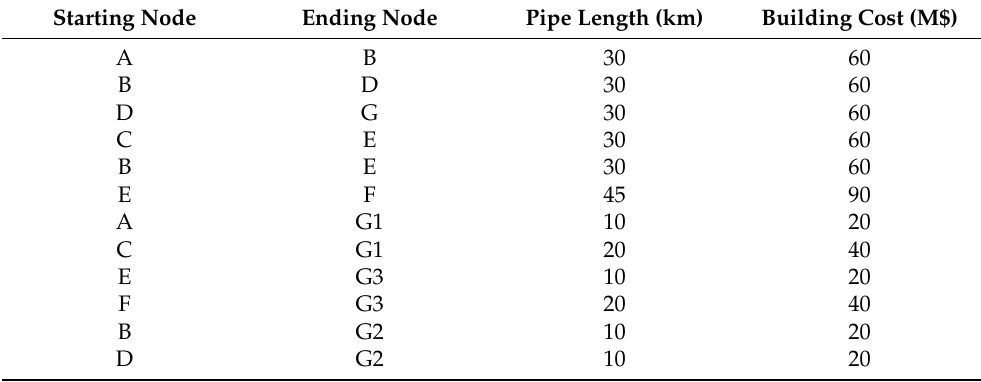
Table A4. Length and cost of pipelines to be selected in the natural gas system. Reproduced from [30,33], IEEE Transactions on Power Systems: 2009 and Proceedings of the Chinese Society of Electrical Engineering: 2017.